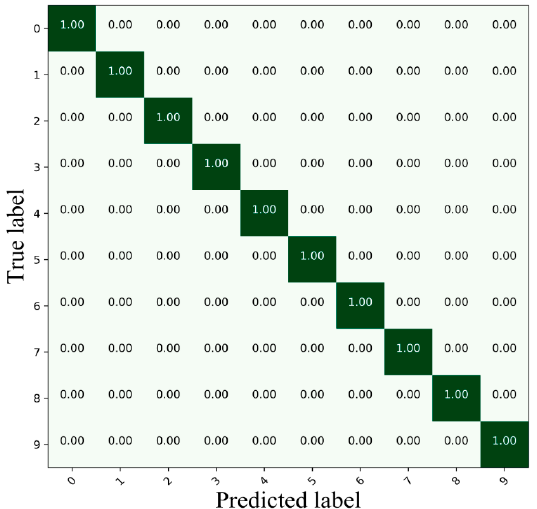
Figure 5. Accuracy rate of various types of fault identification in the testing set.